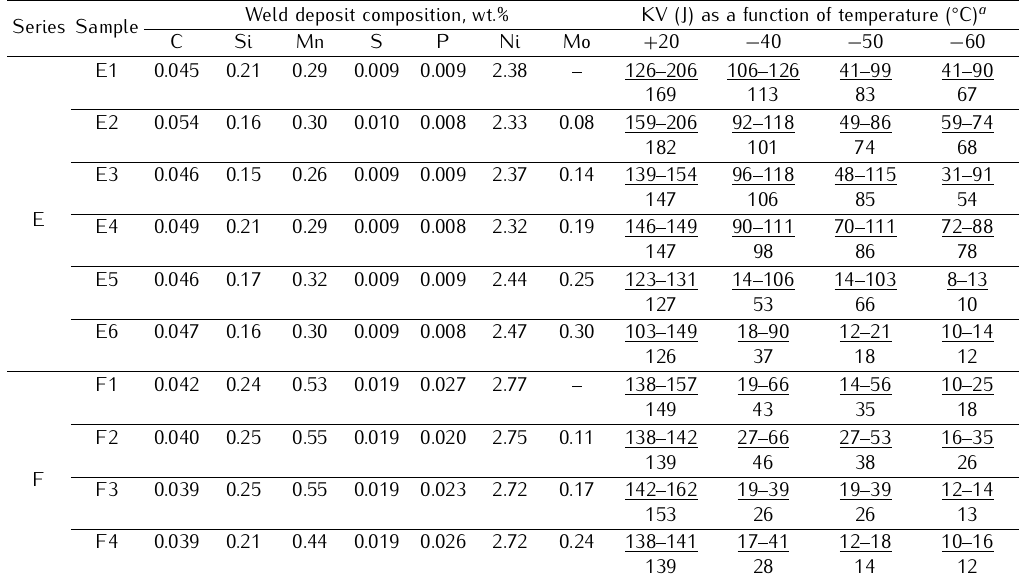
Table 6. Chemical composition and impact energy of weld deposit of experimental covered electrodes of series E and F. Series